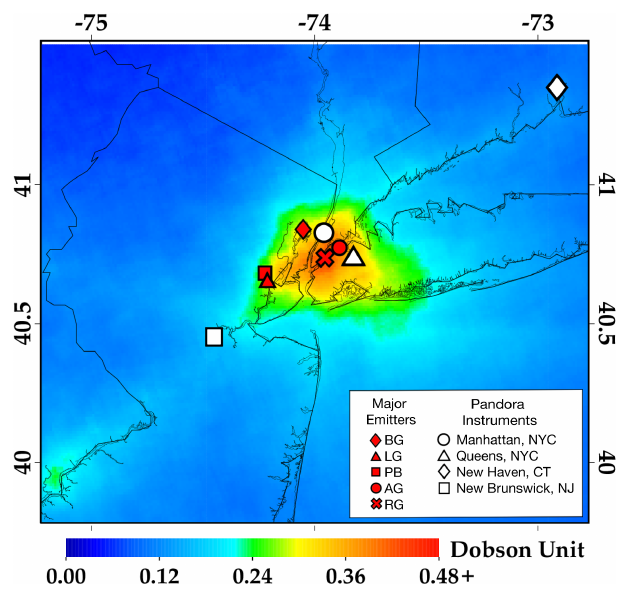
Figure 1. Map of study area, indicating location of Pandora sensors (white symbols) in: Manhattan, NY; Queens, NY; New Brunswick, NJ; and New Haven, CT; overlaid with mean 2019 annual total col- umn NO 2 from TROPOMI (in DU). Major pollutant emitters (red symbols) in the area are included, specifically the PSEG Bergen Generating Station in Ridgefield (BG), the Linden Generating Sta- tion (LG), and the Phillips 66 Bayway (PB) Refinery in Linden (ma- jor emission sources in NJ), and the Astoria (AG) and Ravenswood Generating (RG) Stations in Queens, NY (among the largest green- house gas polluters in the state of NY in 2018 and